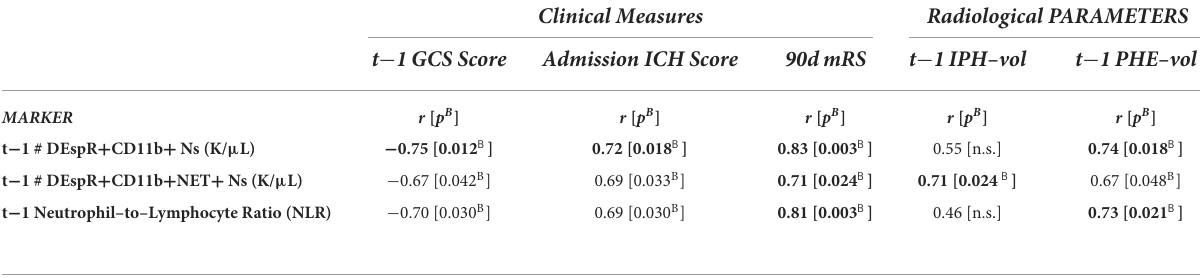
TABLE 3 Spearman rank correlation analysis of top 3 peripheral neutrophil markers with clinical and radiological measures of sICH severity ( n = 13). Clinical Measures